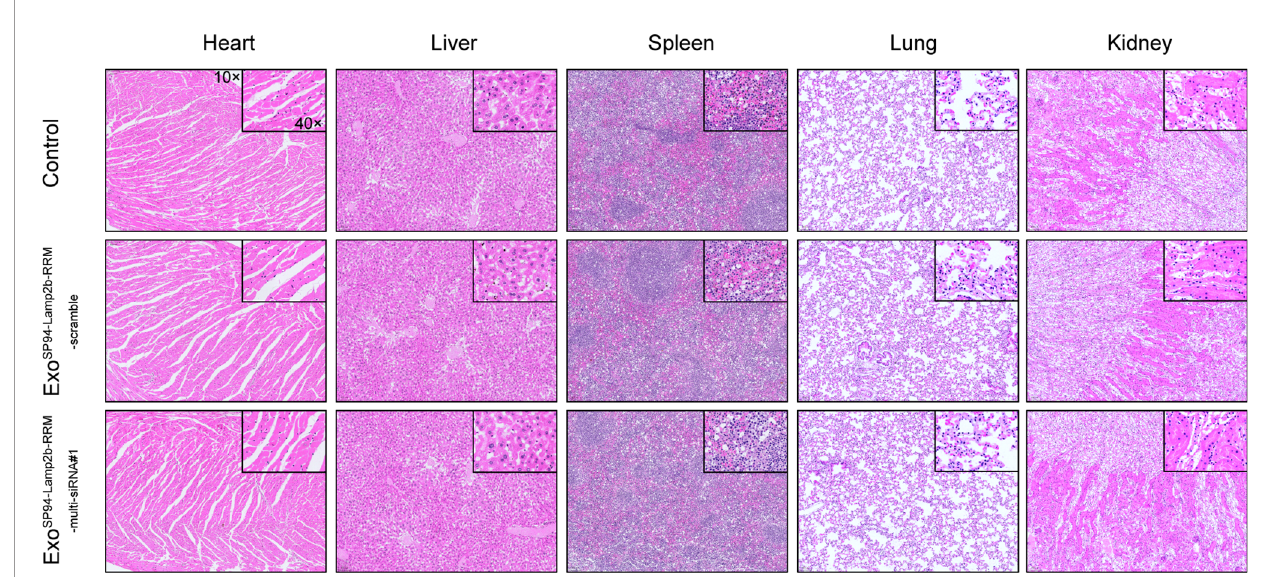
FIGURE 8 | Systemic toxicity evaluation. One hundred micrograms of SP94-Lamp2b-RRM-functionalized exosomes were injected into nude mice via tail vein every 3 days for 21 days. Control: saline; Sora+Exo SP94-Lamp2b-RRM -scramble: sorafenib plus SP94-Lamp2b-RRM-functionalized exosomes containing scramble siRNA; Sora+Exo SP94-Lamp2b-RRM -multi-siRNA#1: sorafenib plus SP94-Lamp2b-RRM-functionalized exosomes containing multi-siRNA#1; Representative hematoxylin-eosin (H&E) staining of the main organs from different treatment groups (scale bar, 100 m